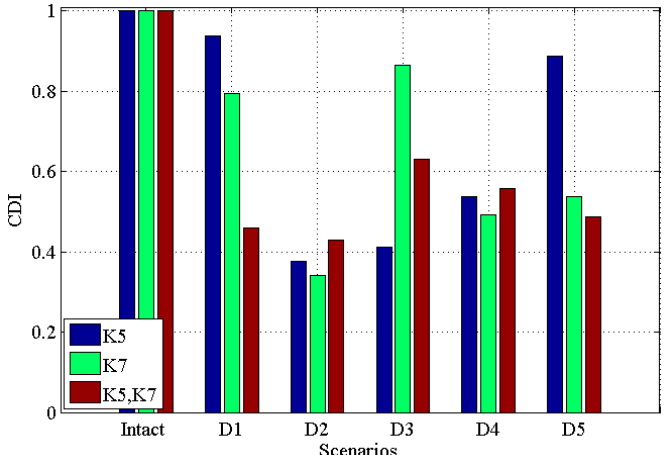
Figure 7. CDI for five damaged scenarios with intact scenario with 5% noise for single damage in K5, single damage in K7, multiple damages in K5 and K7, respectively.